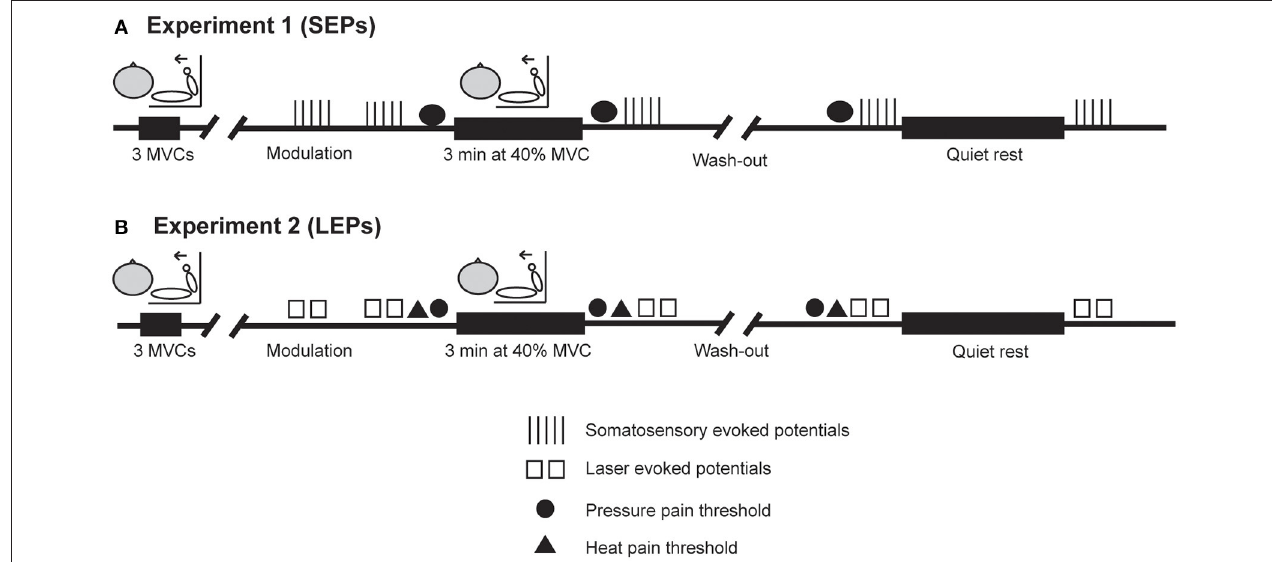
FIGURE 1 | Experimental procedures. (A,B) Show the order of procedures in Experiment 1 (SEPs) and Experiment 2 (LEPs), respectively, when exercise was performed first. In both experiments, evoked potentials were recorded on five occasions during electrical stimulation ( Experiment 1 ) or laser heat stimulation ( Experiment 2 ). Pressure pain thresholds were assessed before and after isometric exercise and before quiet rest in each experiment. Heat pain thresholds were assessed before and after isometric exercise and before quiet rest in Experiment 2 only. A 30min wash out period was included to ensure possible exercise-induced alterations in pain were gone prior to commencing the next block of evoked potential recordings. This was confirmed by the re-assessment of PPTs ( Experiment 1 and 2 ) and HPTs ( Experiment 2 only) prior to the next block of evoked potential recordings. The order of exercise or quiet rest was counterbalanced across participants in each